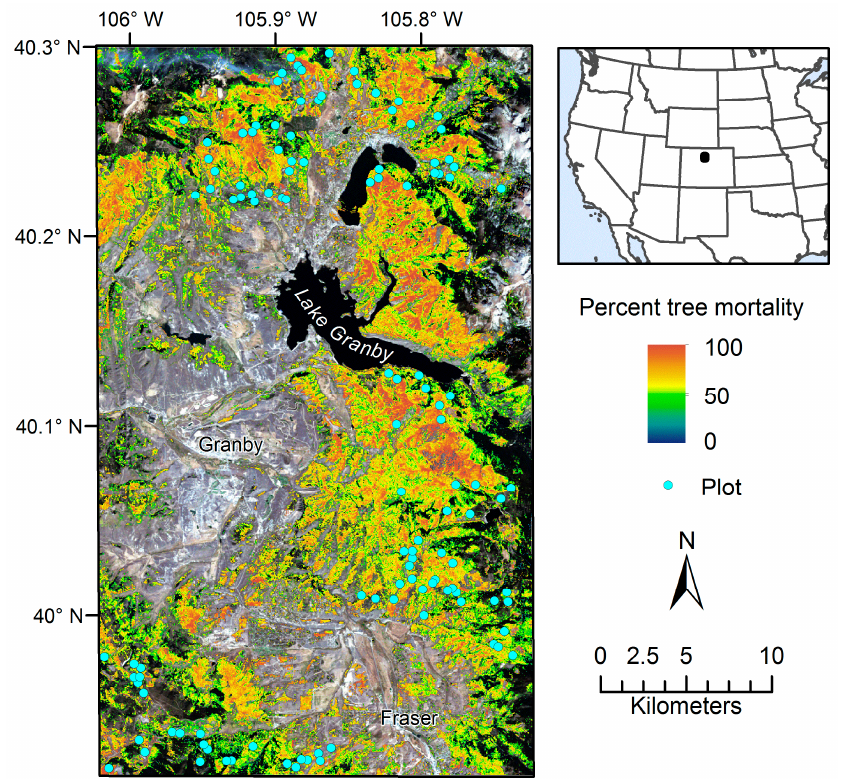
Figure 1. Study area in Grand County in north-central Colorado, USA. Plot locations and cumulative percent tree mortality cover in 2010 [68] are overlaid on true-color Landsat imagery from 25 September 2010. Tree mortality was caused by a mountain pine beetle outbreak that began around 2003 and was subsiding by 2010.